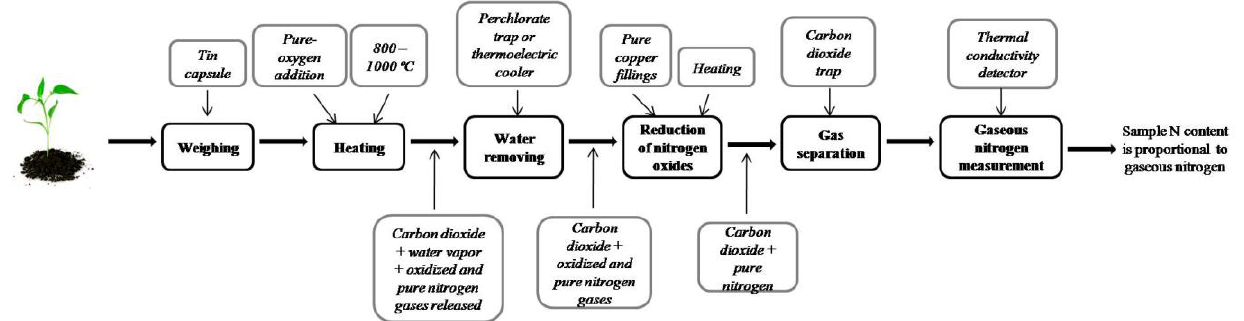
Figure 3. Dumas combustion